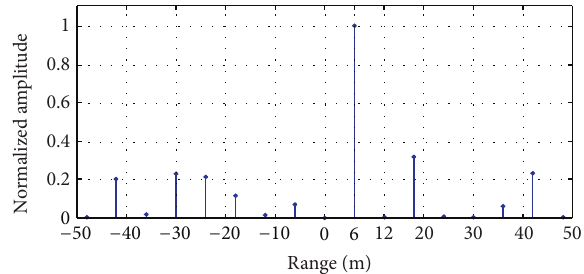
Figure 11: Retrieved signal peaks with the target placed at 6 m.